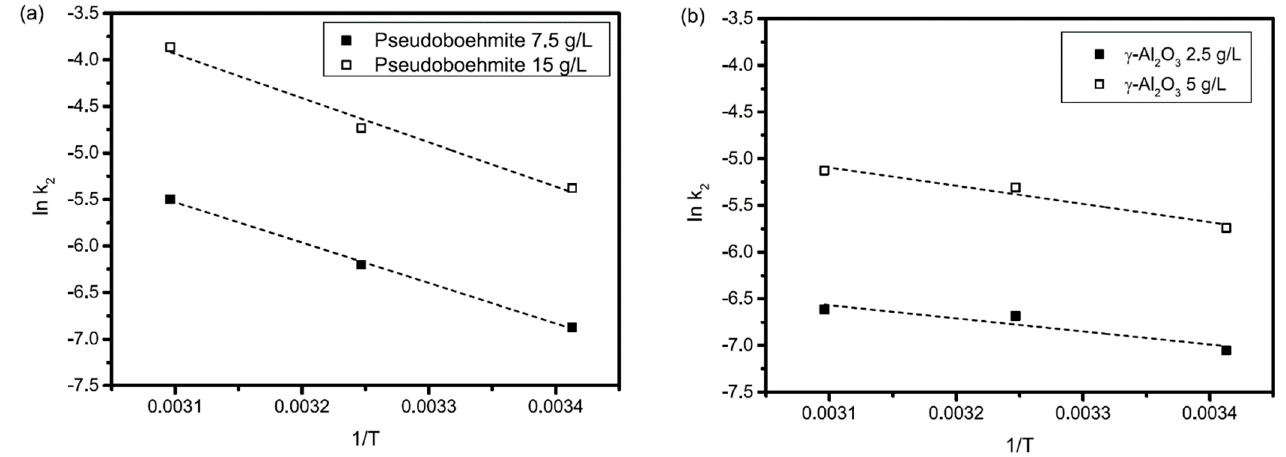
Figure 8. Arrhenius plots for ( a ) pseudoboehmite and ( b ) γ -Al 2 O 3 . Table 4. Activation energy from Arrhenius plots for pseudoboehmite and γ -Al 2 O 3 . Adsorbent Dosage